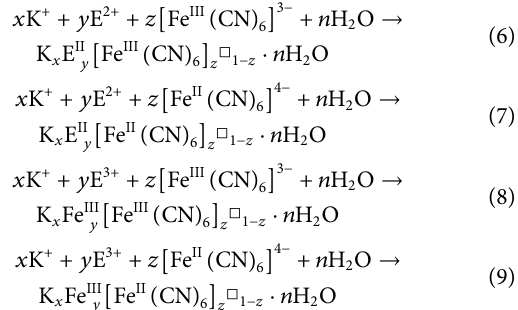
FIGURE 1 | A schematic illustration of the reaction – diffusion – reaction (RDR) setup in which electrochemical reactions to generate reactant ions, diffusionofthereactantionsin fl uencedbyanelectric fi eld,andreactionsofthe reactant ions to form precipitates are coupled to generate precipitation patternsofPBorPBAinagarosehydrogel.Thearrowsindicatethemovement directions of reactant ions in the electric fi